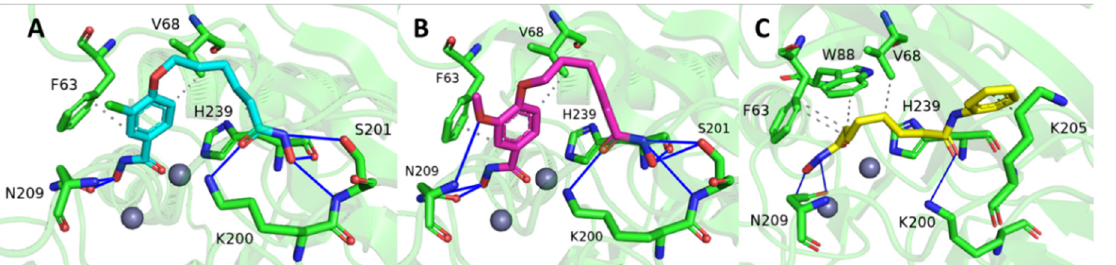
Figure 1. Autodock binding conformations selected for dynamics. ( A ) Compound 4 in cyan, ( B ) Compound 6 in pink, and ( C ) SAHA in yellow.